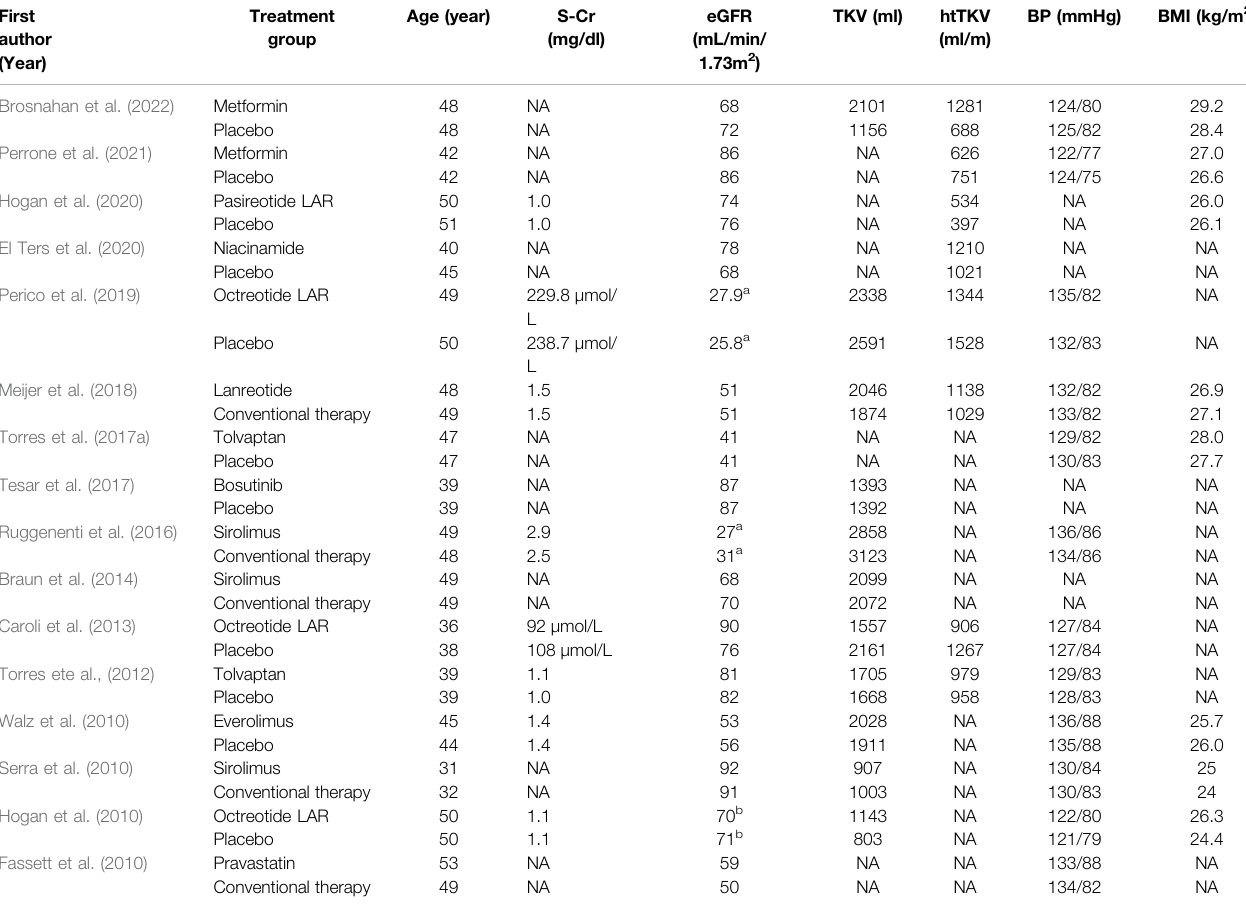
TABLE 2 | Baseline parameters of the individual